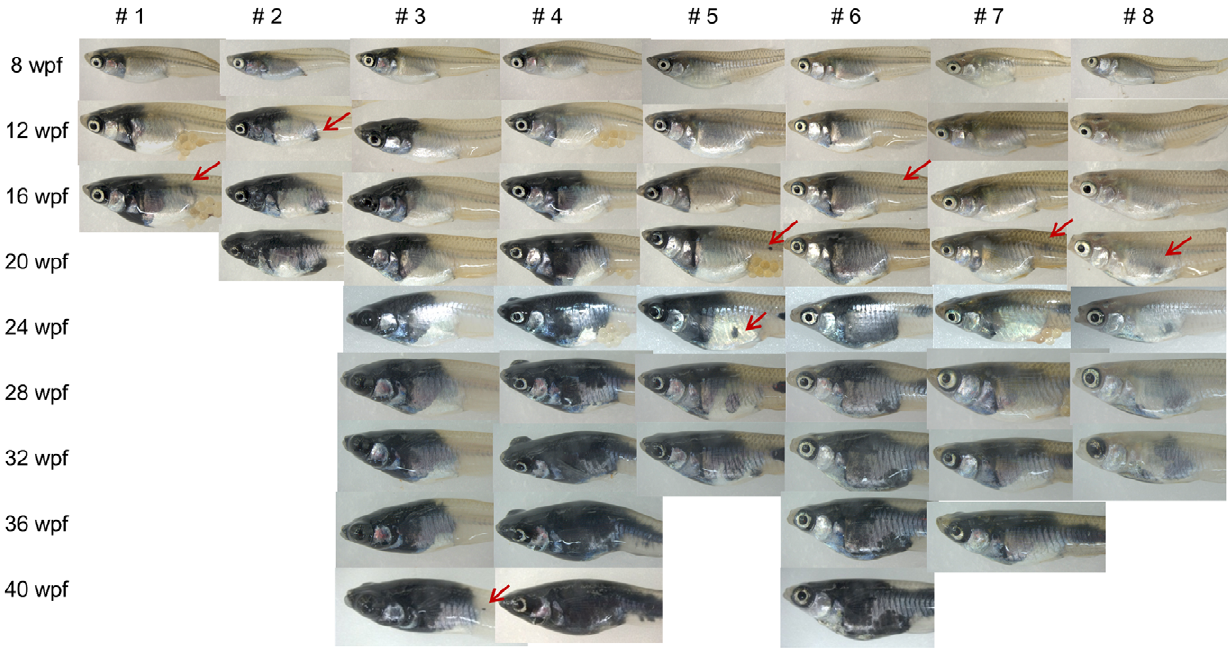
Figure 3. Characteristics of Tg ( tyr:HRAS G12V ) / Tg ( hsp:cre ) medaka. Age-dependent changes in eight double-transgenic fish were monitored after heat treatment at 1 wpf. Five of the eight fish manifested hyperproliferation of pigment cells around the eyes by 8 wpf. All of the fish had developed MPLs with characteristics of infiltrative tumors by 20 wpf, and all had died by 43 wpf. Arrows indicate the first appearance of metastasis-like lesions.